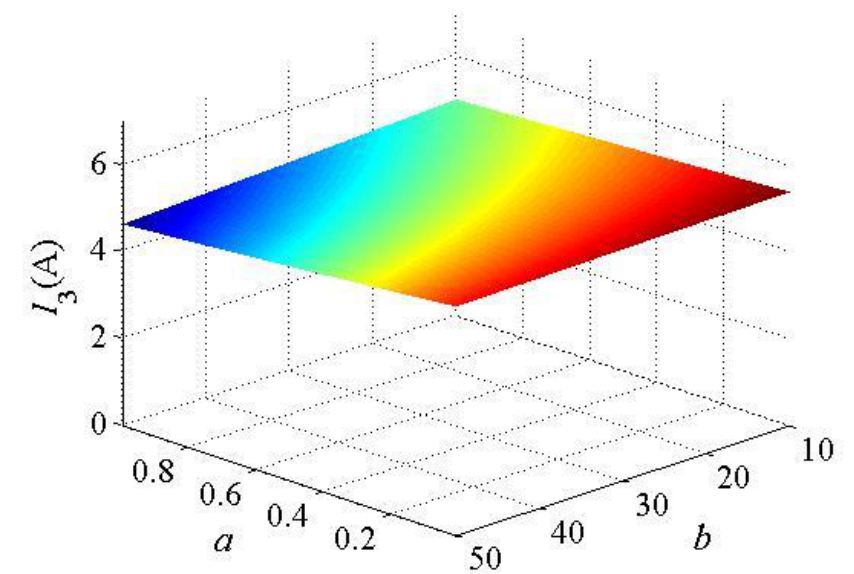
Figure 2. The output current I 3 with parasitic resistances a and b . Figure 3 shows the efficiency of the hybrid topology containing parasitic impedance. It is evident that the system efficiency shows a trend in convex function when the coefficient a rises gradually, which indicates that the parasitic resistance affects the output efficiency. Additionally, the output efficiency drops when the coefficient b rises gradually, which indicates that the load resistance affects the output current. Moreover, the compensation element with parasitic impedance has less influence on the output efficiency than the load.